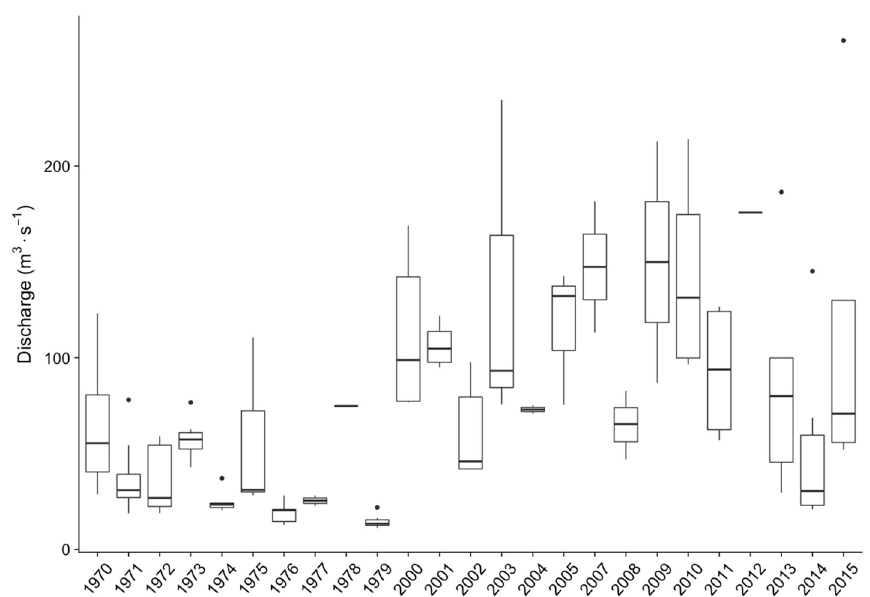
Figure 5. Ice-induced peak discharges before regulation (winters 1970/1971–1979/1980) and after regulation (winters 2000/2001–2015/2016). The bold line is the median, the box shows the interquartile range(IQR), the whiskers 1.5 · IQR, and the circles show outliers.